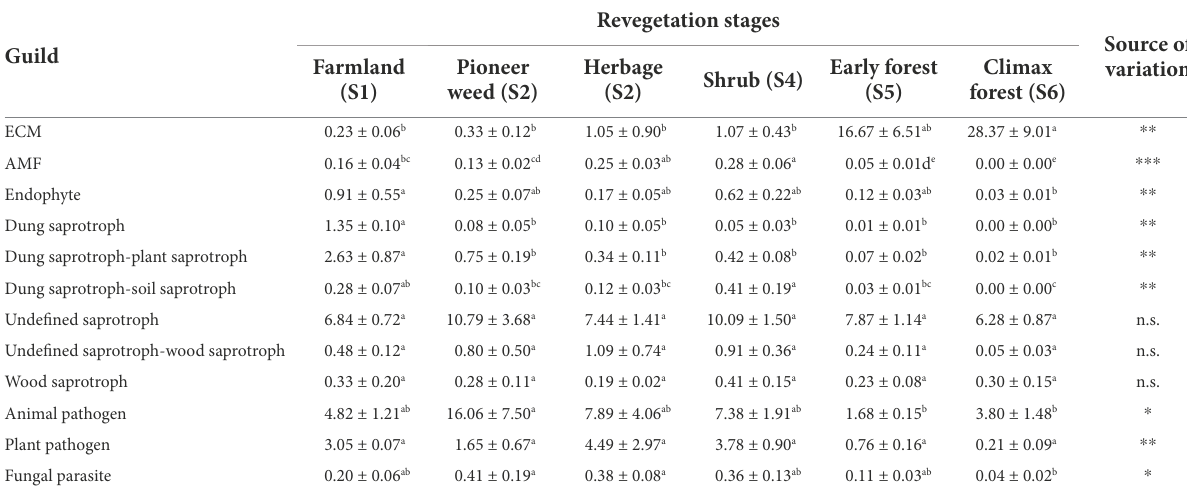
TABLE 4 Relative abundance (%, sequences; mean ± SE, n = 4) of assigned fungal functional guilds in symbiotroph, saprotroph and pathogen in the soil (0–20 cm depth) microbial communities during various revegetation stages in the Loess Plateau of China, inferred by FUNGuild.